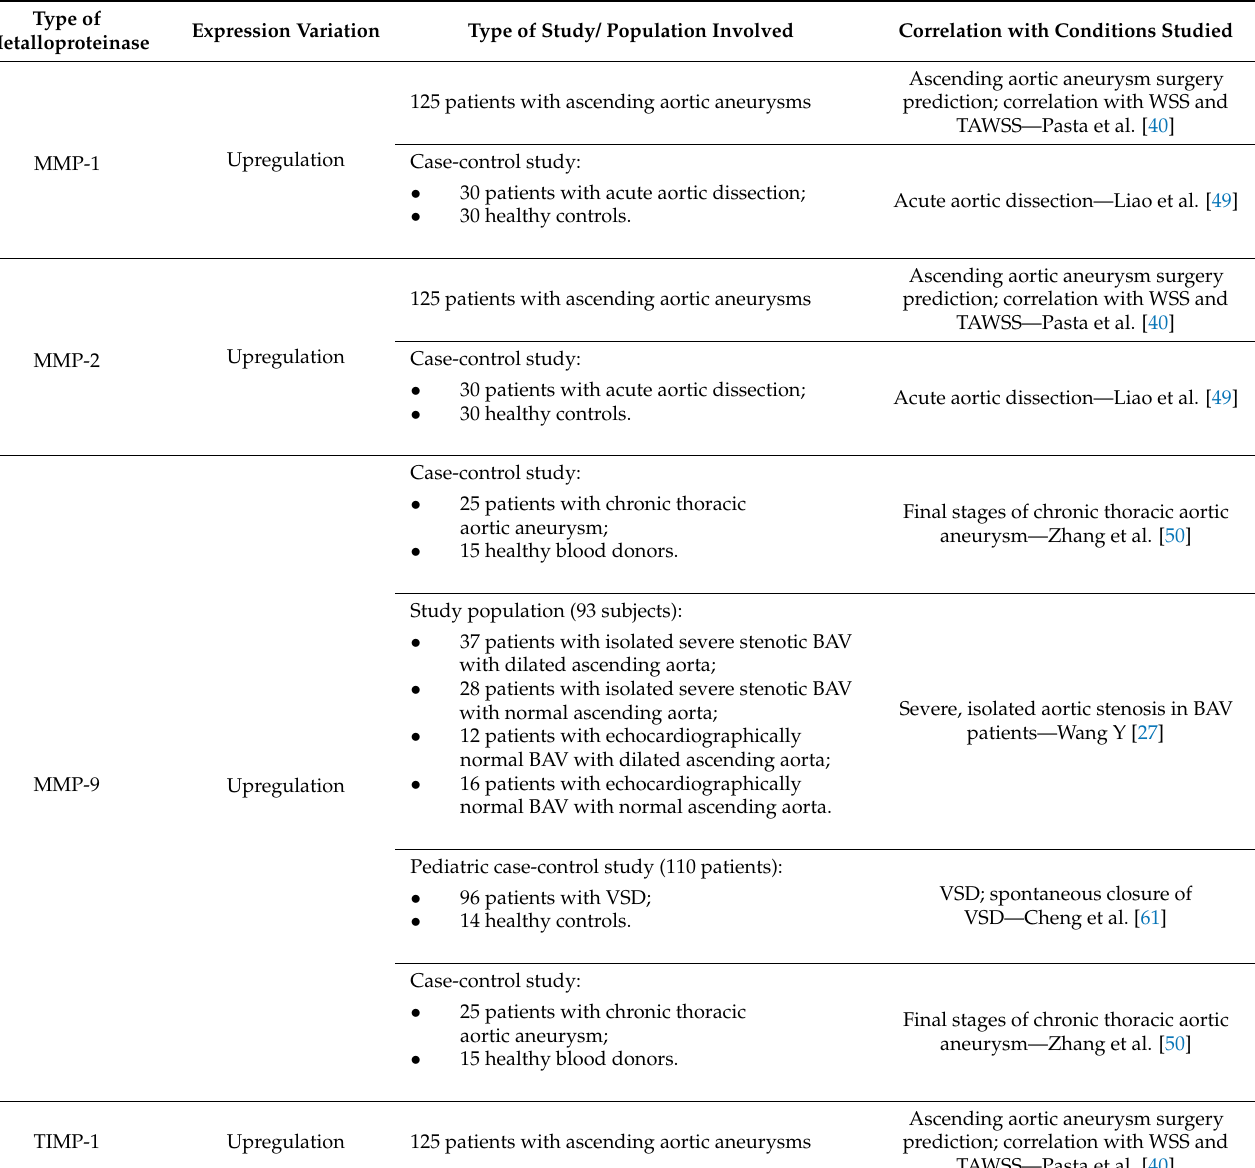
Table 2. Summary of literature data sustaining biomarker role of circulating MMP-1, MMP-2, MMP-9 and TIMP-1 among several aortic-related